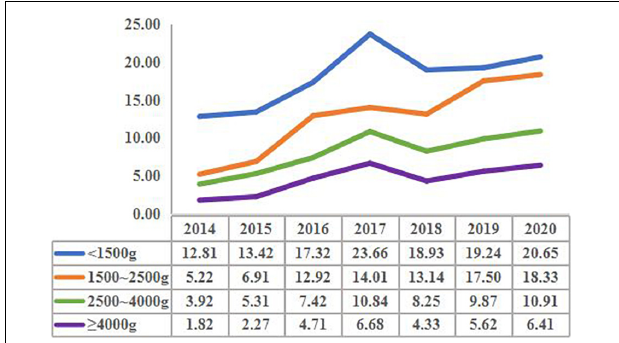
FIGURE 1 | The prevalence of congenital heart disease in children with different birth weights in different years (per 1,000